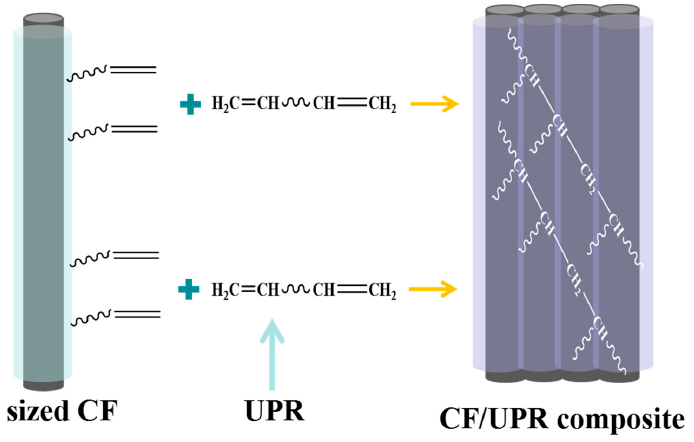
Figure 12. Interfacial reaction mechanism diagram of CF sized by polyester sizing agent with UPR.